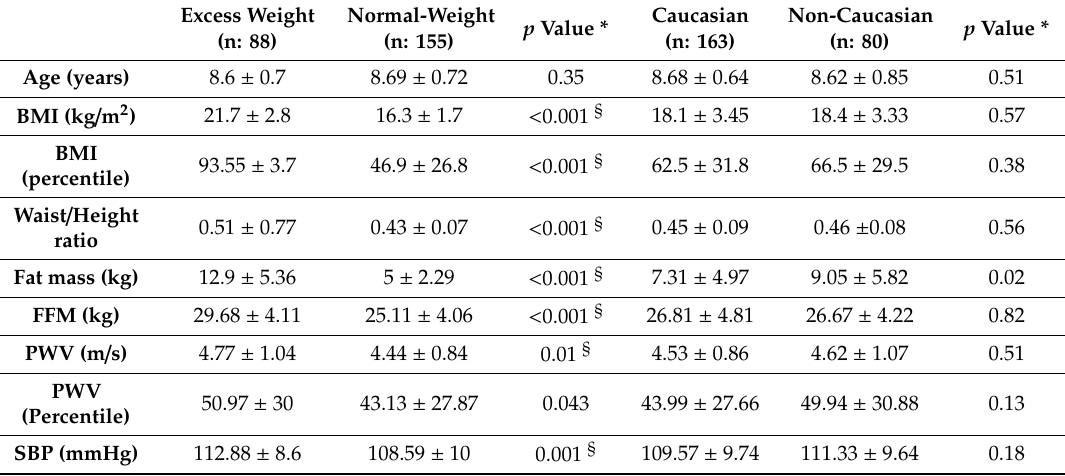
Table 1. General characteristics of the population, split by weight and